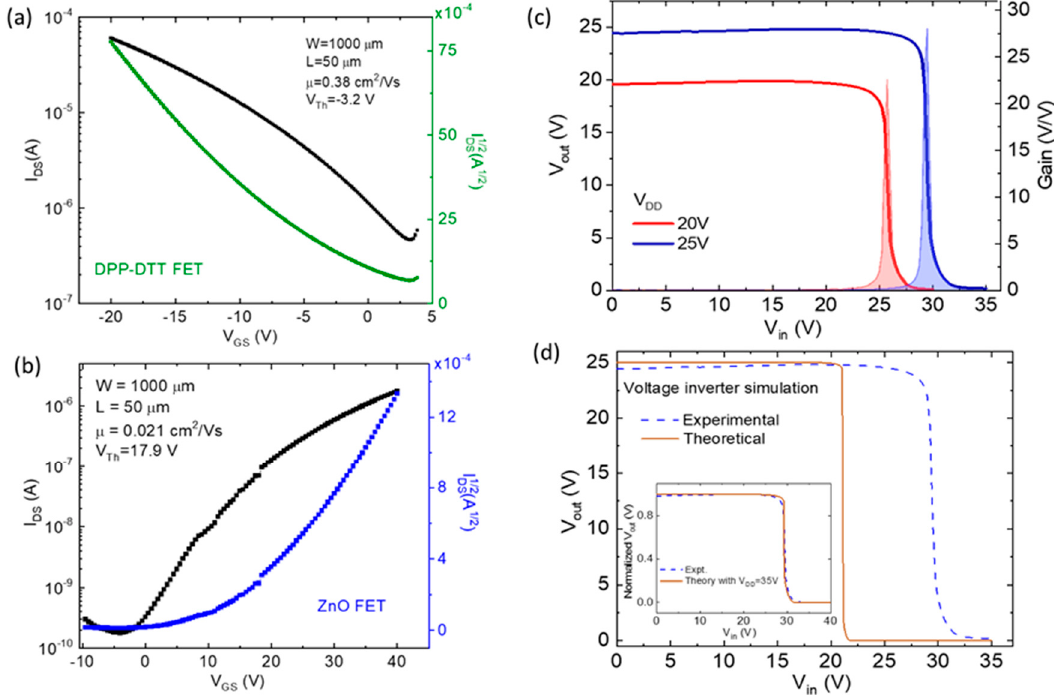
Figure 4. ( a ) Transfer characteristics of DPP-DTT FET using V-poled PVDF-TrFE as the dielectric (V DS = − 25 V). ( b ) Transfer characteristics of ZnO FET (V DS = 40 V). Both of these FETs were used in the inverter circuit. ( c ) DC output characteristics of the complementary inverter at V DD of 20 V and 25 V. The corresponding gain is shown by the shaded curves. ( d ) Simulated inverter output characteristics (bold brown line) along with the experimental data (dotted blue line). The inset shows the normalized experimental curve (same as in the main figure) and theoretical simulated curve at V DD = 35 V.